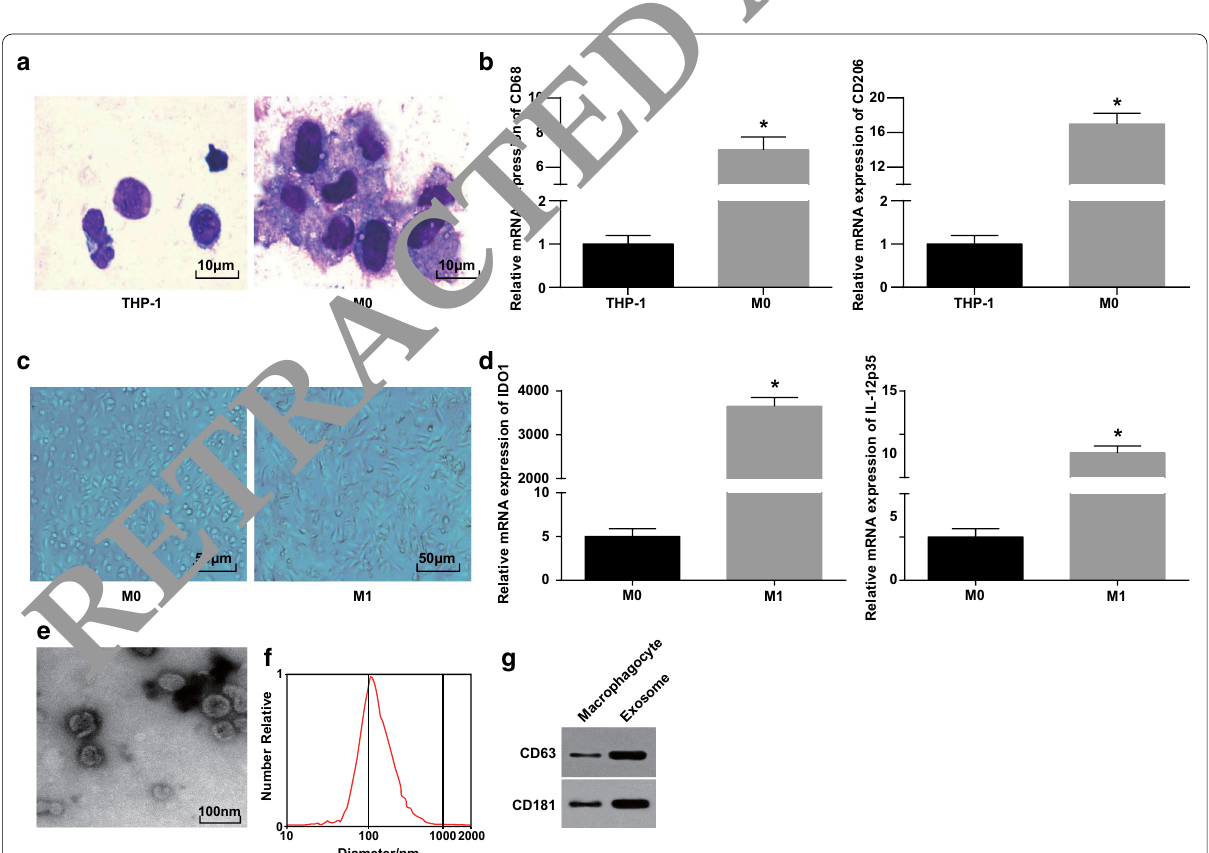
Fig. 1 Identification of M1 macrophage and exosomes. a Wright’s staining for observing the morphology of THP‑1 cells before and after PMA treatment. b CD68 and CD206 expression in THP‑1 cells and PMA‑treated THP‑1 cells detected by RT‑qPCR; c morphology of macrophages and M1 macrophages. d Expression of IDO1 and IL‑12 p35 in M0 macrophages and LPS and INF‑γ‑treated M0 macrophages detected by RT‑qPCR. e TEM for exosomes observation. f Detection of particle size distribution of exosomes by NTA. g Protein bands of CD63 and CD181. In panel b, * P < 0.05 versus THP‑1 cells; In panel d, * P < 0.05 versus M0 macrophages. Measurement data were depicted as mean between two groups were conducted by t